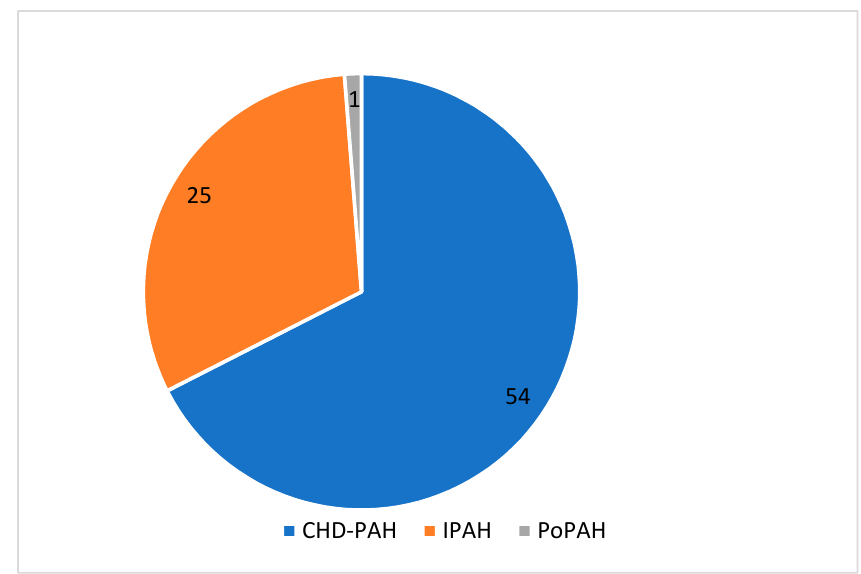
Figure 2. Distribution of different classes of pulmonary arterial hypertension in the study group. CHD-PAH, pulmonary arterial hypertension associated with congenital heart disease; IPAH, idiopathic PAH; PoPAH, portopulmonary PAH. Table 1. The prevalence of di ff erent heart defects in four subgroups of patients (CHD-PAH: n = 54) according to the European Society of Cardiology.